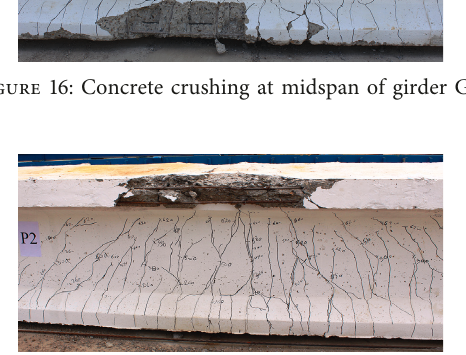
Figure 17: Concrete crushing at midspan of girder P2. Figure 18: Load–net deflection curves for girder G2 under repeated loading.